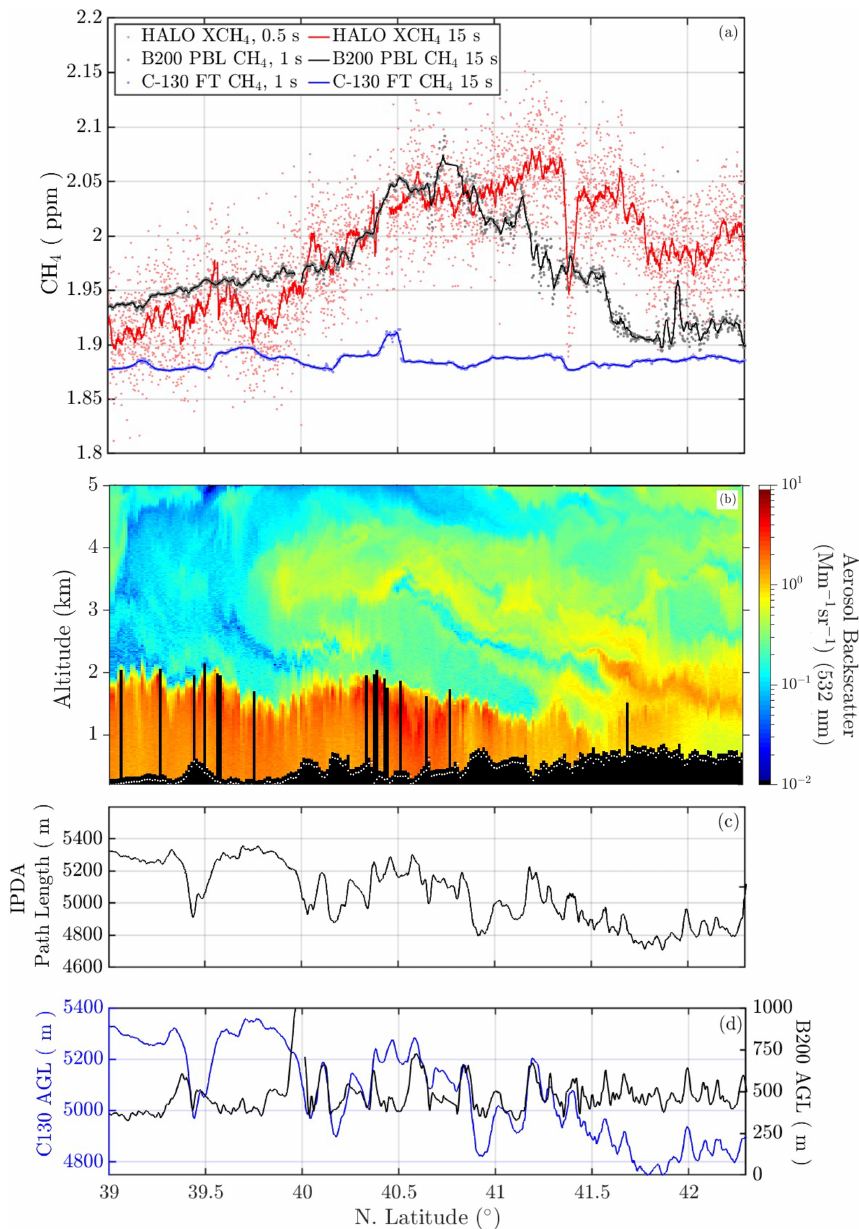
Figure 13. South–north transect, 39–42.3 ◦ N, of Pennsylvania from Fig. 12. (a) Mole fractions measured by each instrument, HALO column XCH 4 in red, the B200 PBL in situ CH 4 in black, and C-130 in situ FT CH 4 in blue. (b) Cloud-cleared (black vertical lines) HSRL aerosol backscatter at 532nm during the transect and DEM height, white dots. (c) IPDA path length. (d) Altitude above ground level (a.g.l.) time series of each